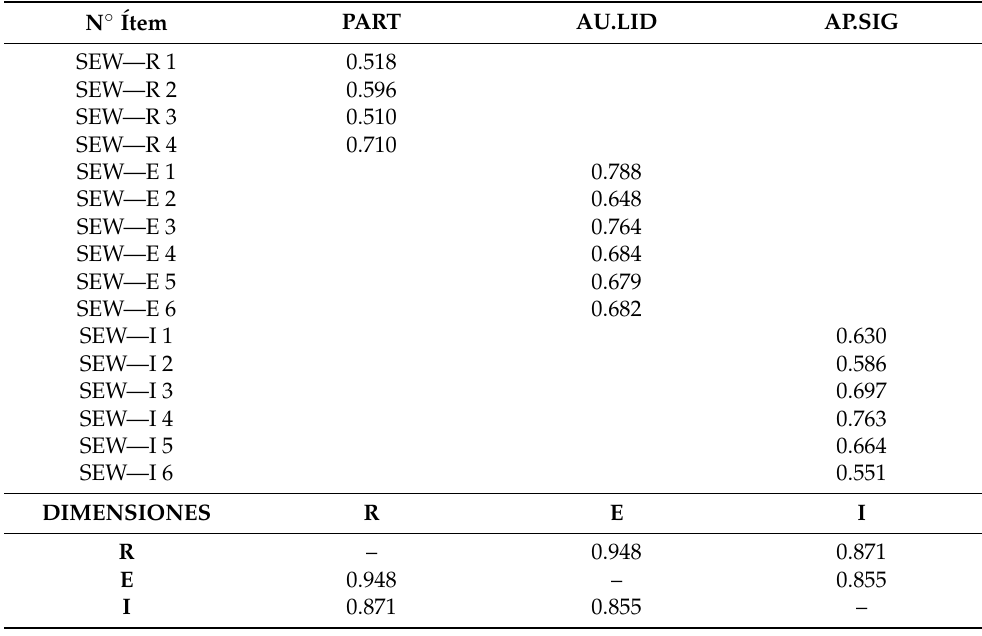
Table 6. Confirmatory Factor Analysis. REI Scale ( n = 156 students of Agrarian Schools, members of FFs). N ◦ Í tem PART AU.LID